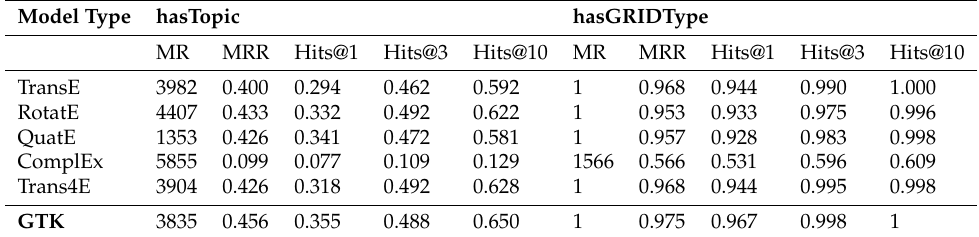
Table 2. Evaluation results on the AIDA academic knowledge graph.